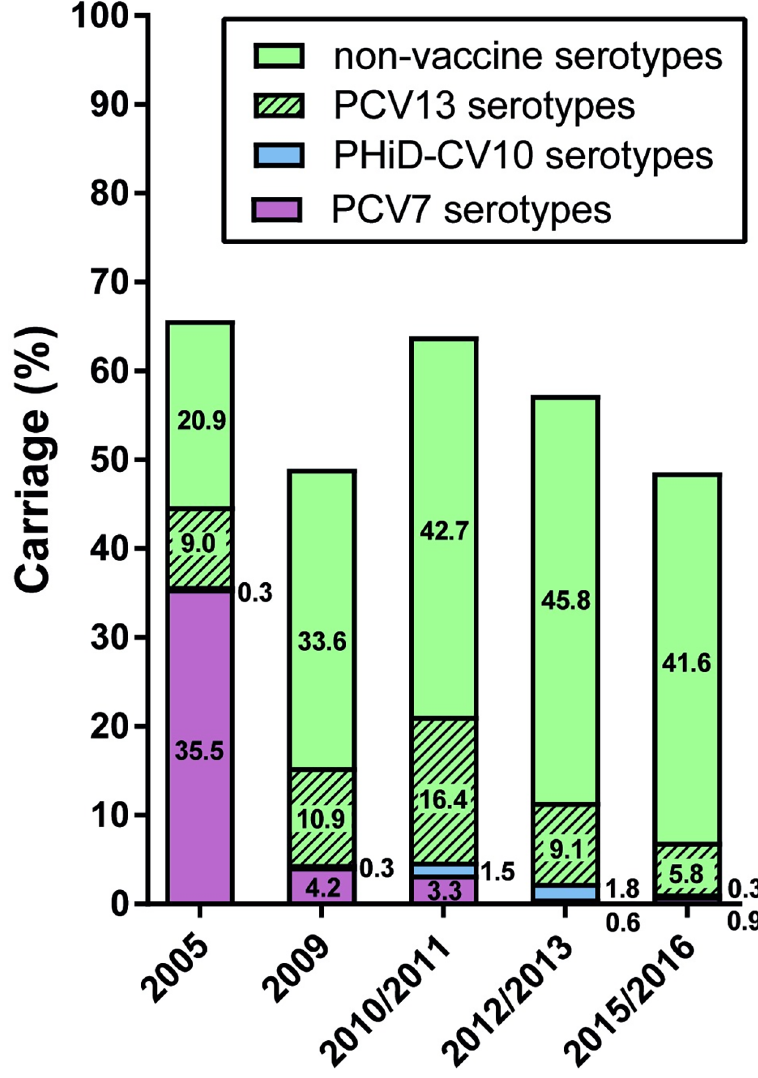
Fig 1. Carriage rates of S . pneumoniae in 24-month-old children. PCV7 serotypes include serotypes 4, 6B, 9V, 14, 18C, 19F and 23F. PHiD-CV10 shows the additional serotypes 1, 5 and 7F. PCV13 shows the additional serotypes